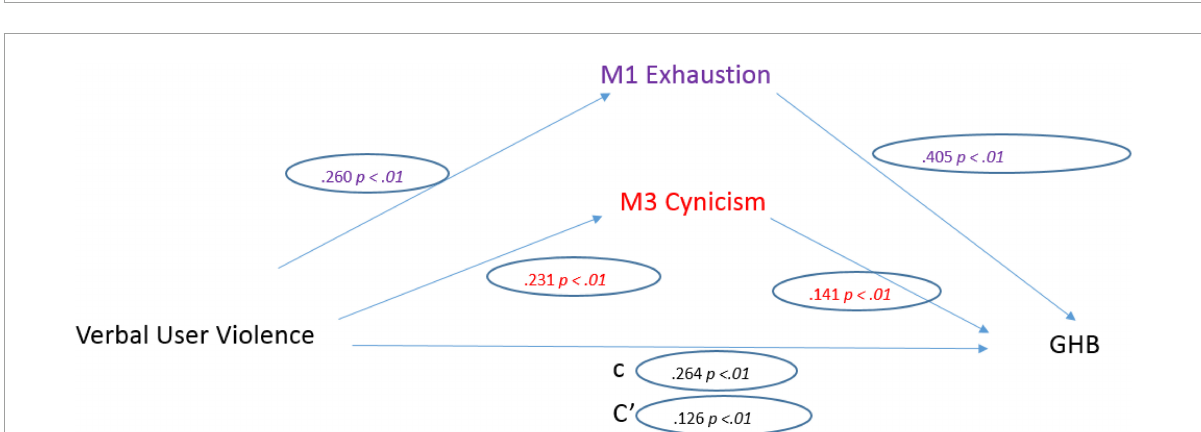
FIGURE4 Physical user violence model.